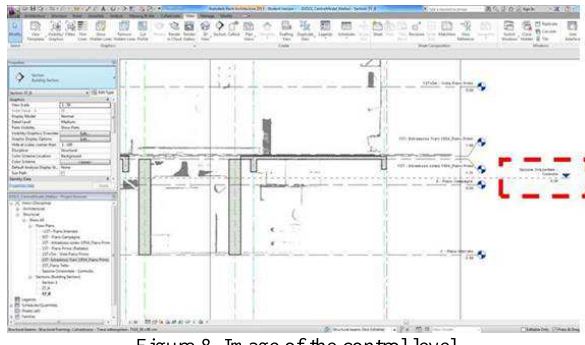
Figure 8. Image of the control